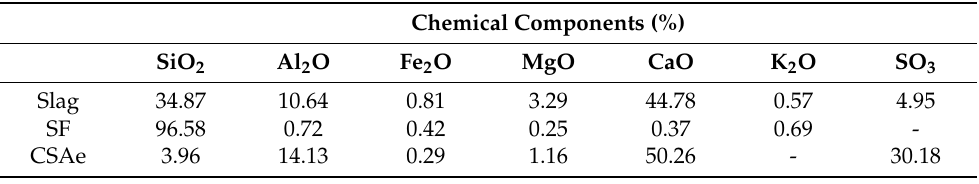
Table 1. Chemical properties of materials.